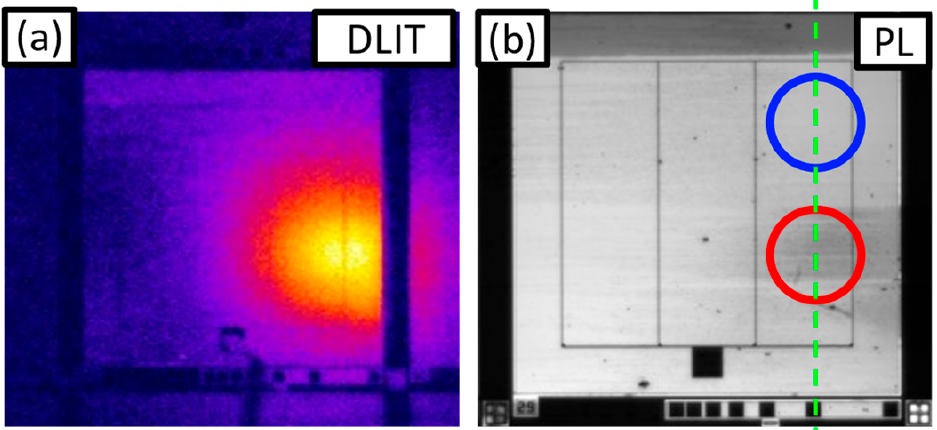
Figure 5. ( a ) DLIT and ( b ) PL images of a GaAs solar cell grown on partially planarized spalled wafers. These DLIT images were taken at a forward bias current of 20 mA/cm 2 . The blue and red circles in ( b ) denote complete and incomplete planarized regions, respectively. This device was cleaved approximately through the green dashed line for cross-sectional analysis.